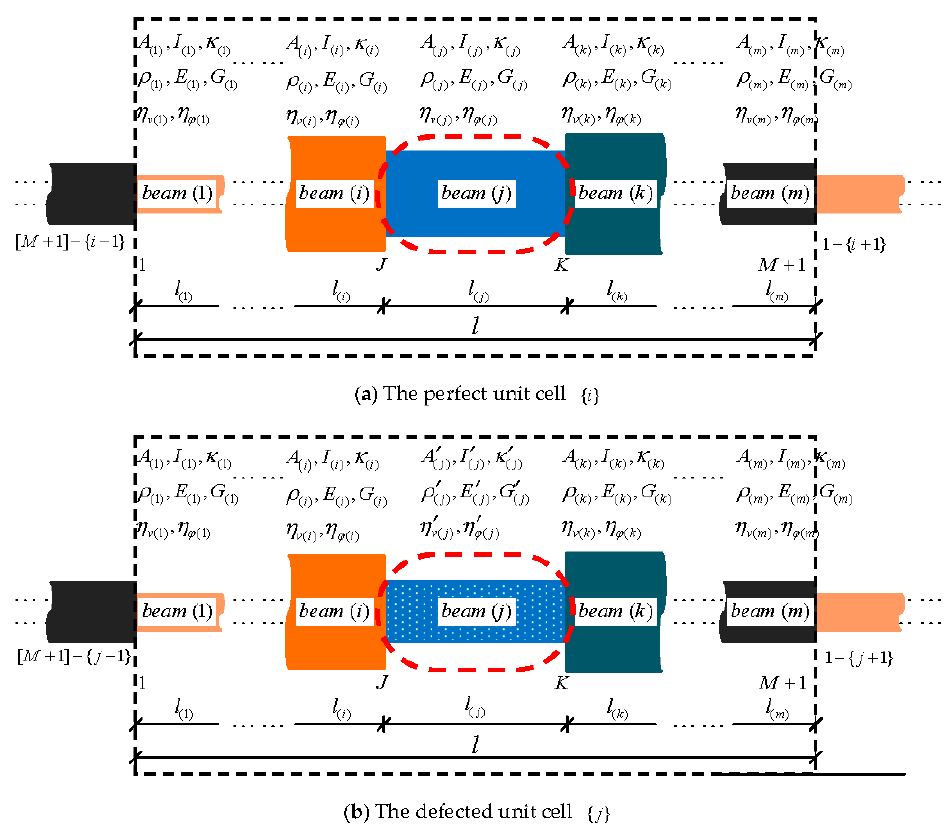
Figure 2. The configuration of: ( a ) The perfect unit cell { i } ; ( b ) The defected unit cell { j } .